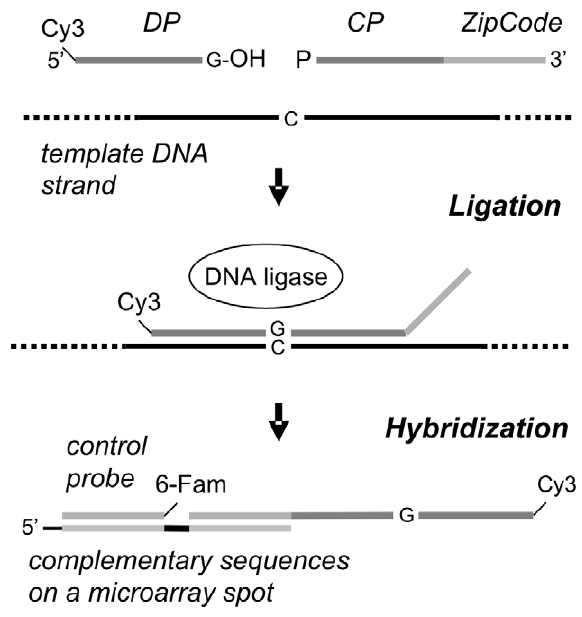
Figure 1. The principle of ligation detection reaction. The discriminating probe (DP) and the common probe (CP) are designed to hybridize adjacently on the template DNA and are joined by ligase in the presence of a matching template (HPV PCR product). The discriminating 3 9 base can be A, C, T or G. The reaction is thermally cycled and ligation products addressed on microarray spots by the unique ZipCode sequences flanking each CP. Hybridization control probe carries a different label (6-Fam) than the DP